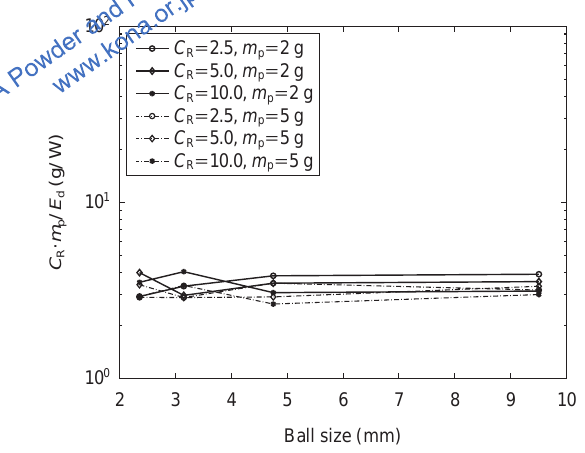
Computed changes of the function C R · m p / E d for different ball sizes and different charge ratios.